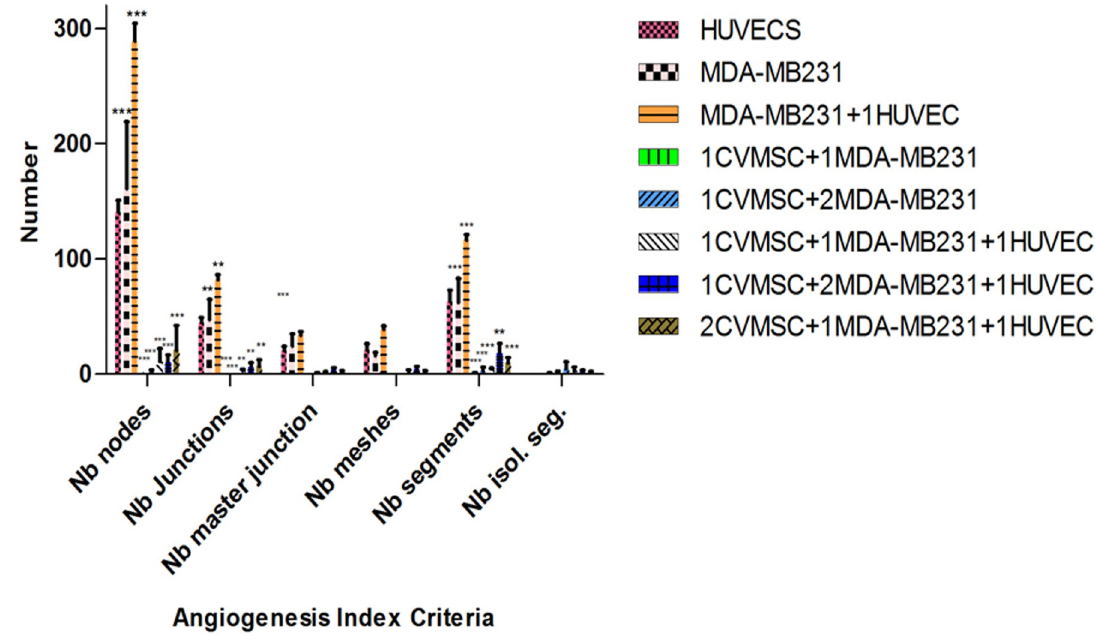
Fig 10. Statistical computation of angiogenic parameters using angiogenesis analyzer macro connected image J software. The bars show a comparison between untreated MDA-MB231 and treated MDA-MB231 with different ration of CVMSCs in the presence of HUVECs or not. Nb = number. All the groups were analyzed by Two-way ANOVA and each group was compared to the positive group (HUVECs). HUVEC = human vascular endothelial cells, CVMSC = of human placental chorionic villi derived MSCs.